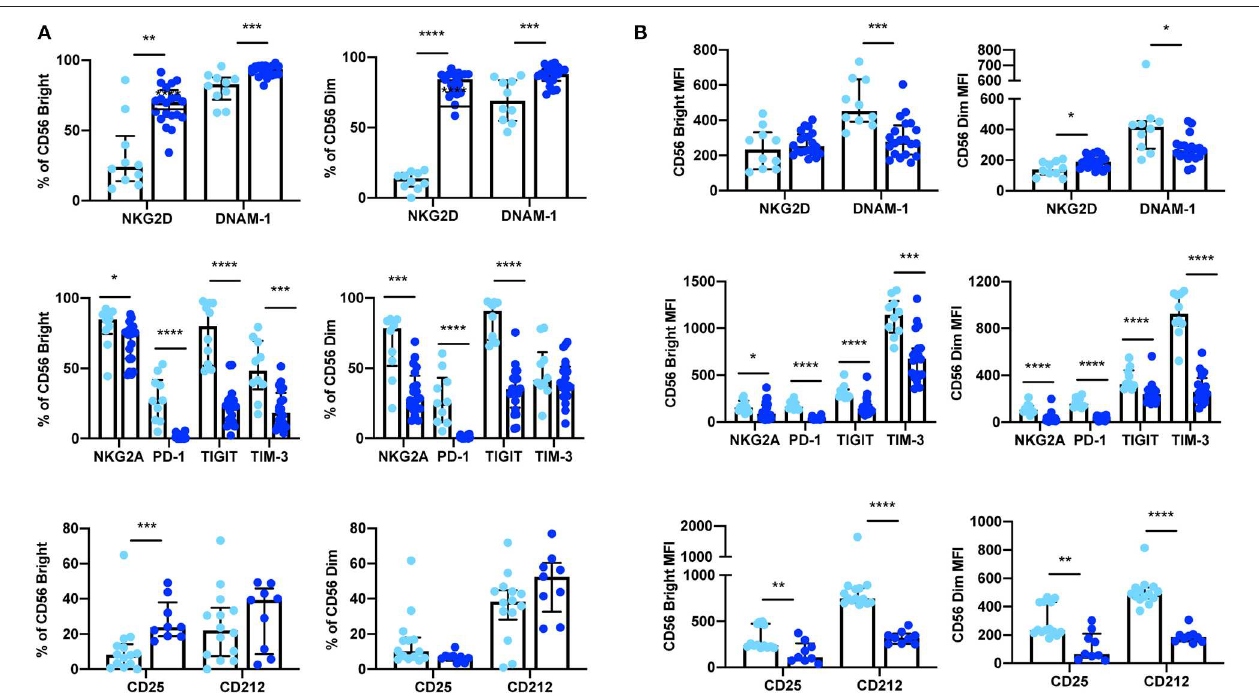
FIGURE 3 | Expression of extracellular surface receptors differs between cryopreserved PBMCs and whole blood samples. A significant difference was observed between the percentage of CD56 Bright / Dim CD3 − cells expressing all activating and inhibitory receptors (cryopreserved n = 10, whole blood n = 20), as well as the cytokine receptor subunits CD25 and CD212 (cryopreserved n = 14, whole blood n = 11) (A) . In addition, a significant difference was also observed in the relative expression levels (MFI) of these receptors in both CD56 Bright and CD56 Dim populations (B) . Shown are the median values ± IQR. The Mann-Whitney test was used to assess statistical significance. p ≤ 0.05 (* p ≤ 0.05, ** p ≤ 0.005, *** p ≤ 0.0005, **** p ≤